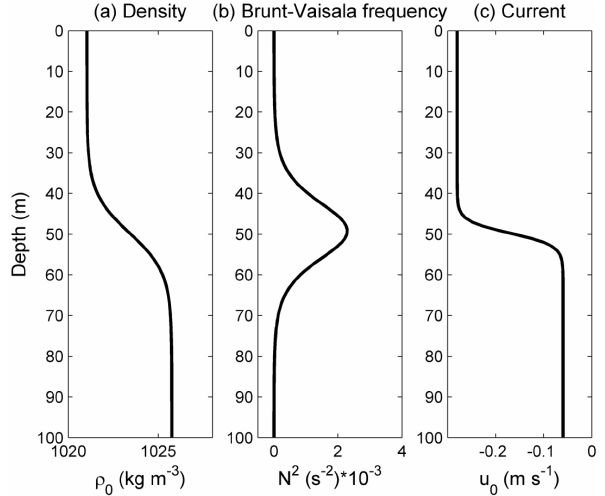
Figure 1. Vertical profiles of the (a) density, (b) buoyancy fre- quency and (c) background velocities in the control experiment (case O5).